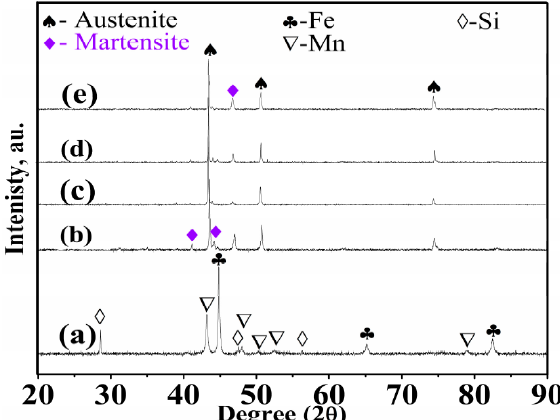
Figure 8. XRD results on the middle parts (outside the LD region) of the ternary Fe-28Mn-3Si alloys sintered at 1200 °C for different isothermal holding times. ( a ) Green compact before sintering; ( b ) MM alloys without isothermal holding; ( c ) MM alloys with 1 h isothermal holding; ( d ) MM alloys with 2 h isothermal holding; ( e ) MM alloys with 3 h isothermal holding.